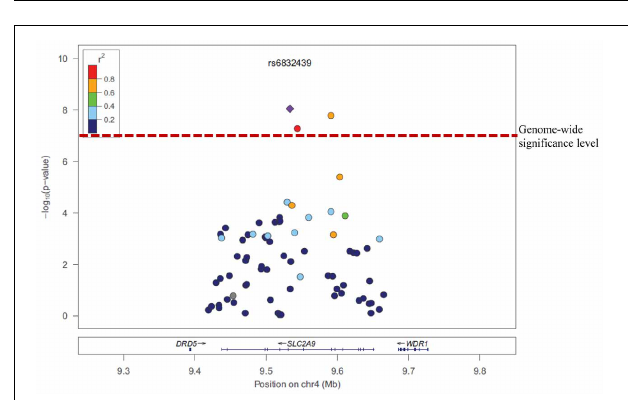
FIGURE 3 | Genome-wide association analysis of serum uric acid.